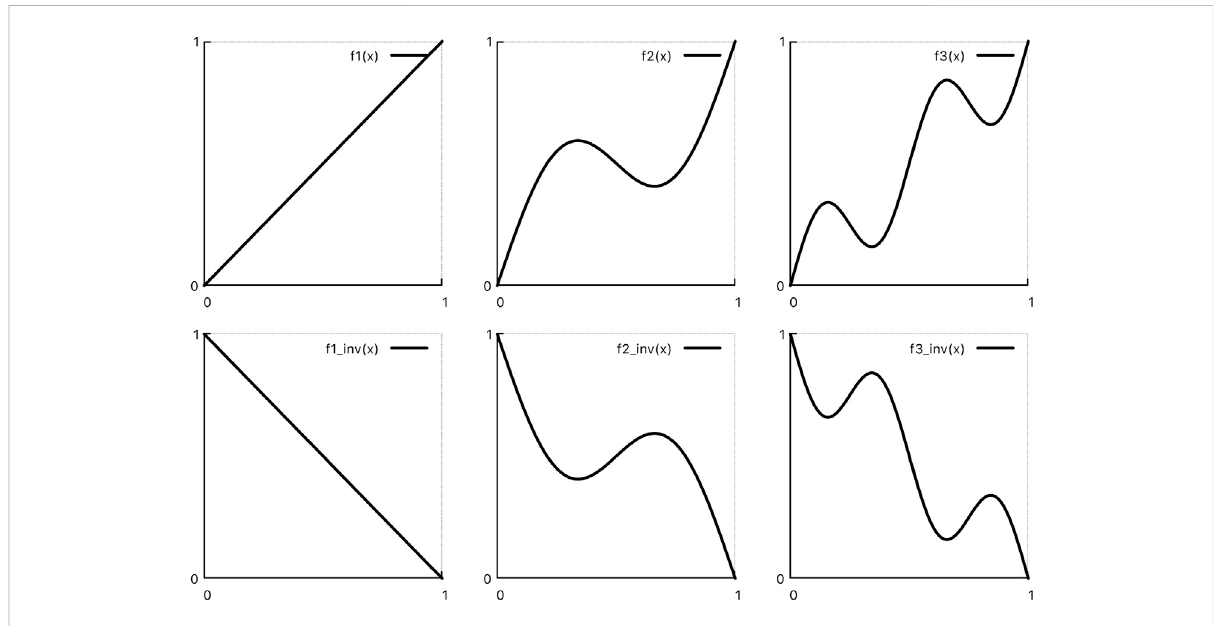
FIGURE 2 The six functions used to render the soni fi cations of the feature values.